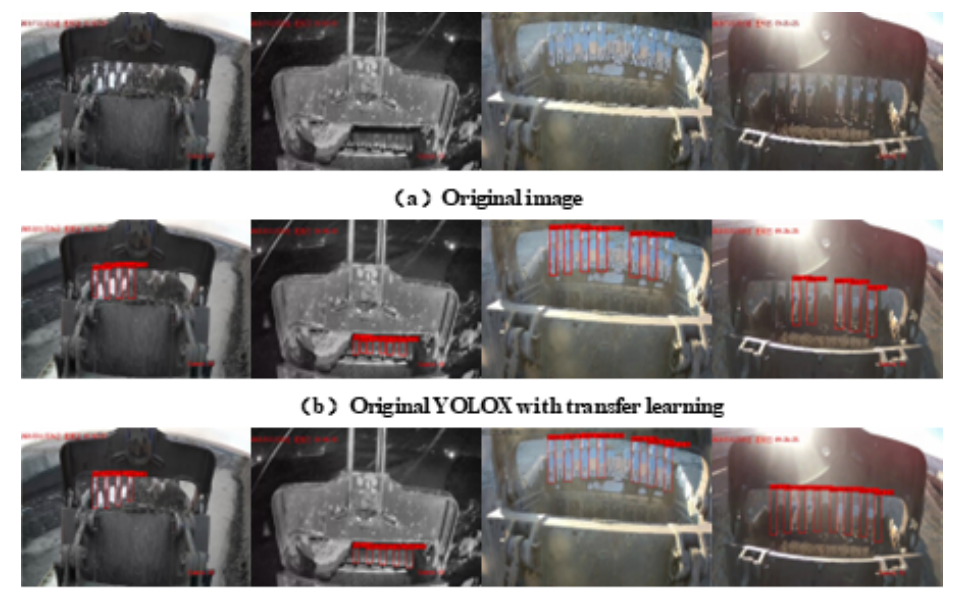
Figure 13. Comparison of migration test